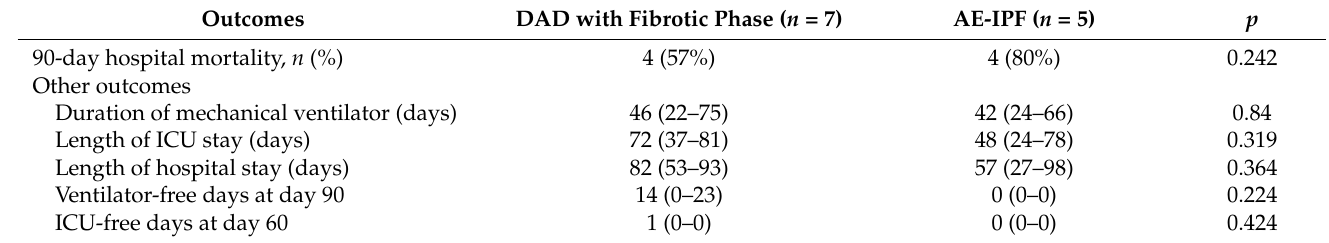
Table 3. Clinical outcomes as a function of DAD with a fibrotic phase and AE-IPF on histological findings. Outcomes